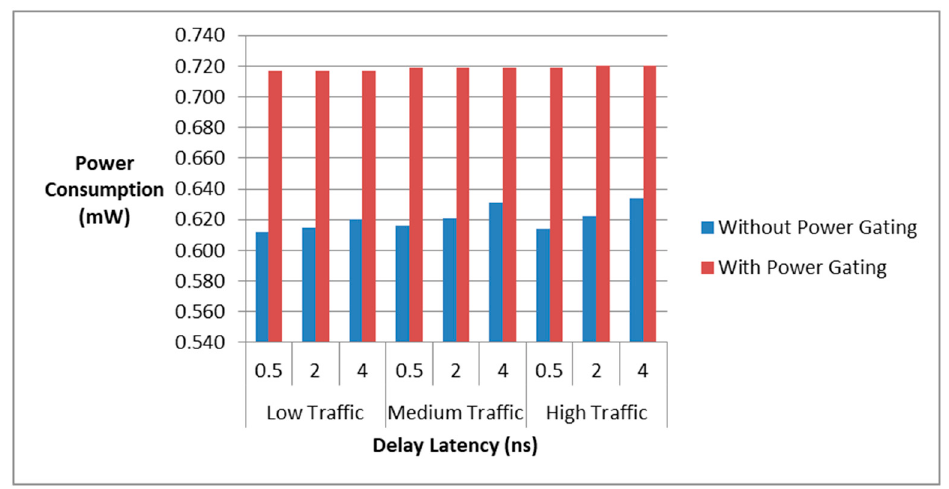
Figure 15. The power comparison showing the impact of power gating application under various traffic points and frequencies.